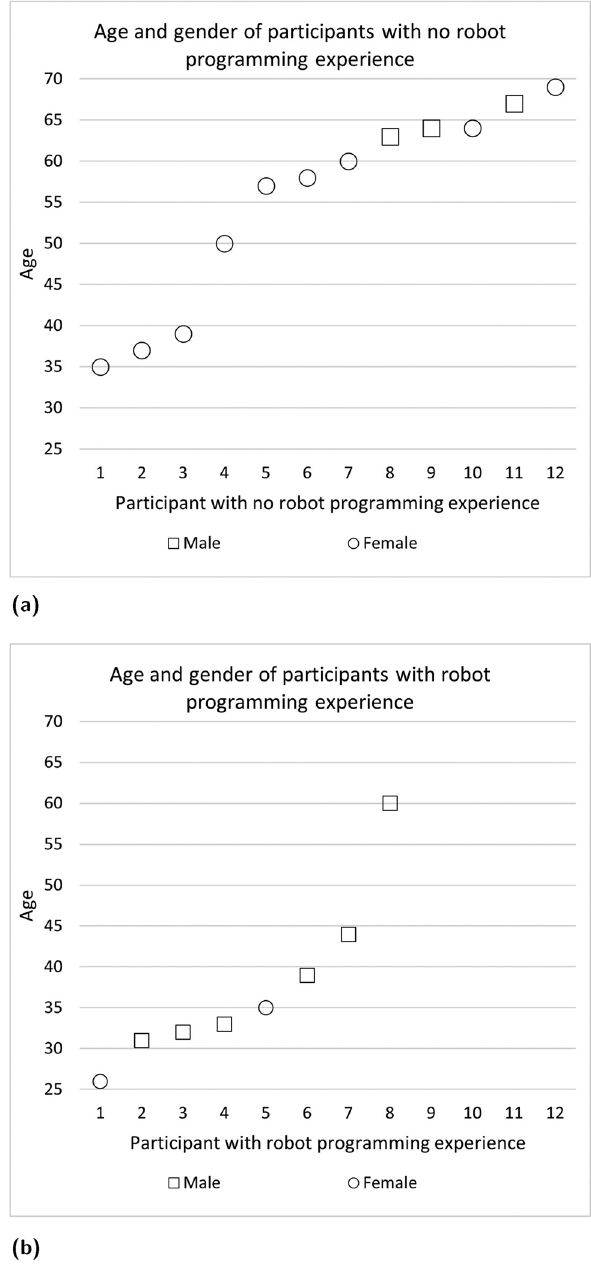
Figure 7: Demographics of participants ’ gender, age and robot programming experience. ( a ) Demographics of participants with no robot programming experience. ( b ) Demographics of participants with robot programming experience. the participant or experimenter would ring the physical doorbell in the Robot House and check that the resulting robot actions were correct. Three individual behaviours were taught in the training phase. These were chosen to be relatively simple but also to exercise the speech, movements and diary functions of the robot.